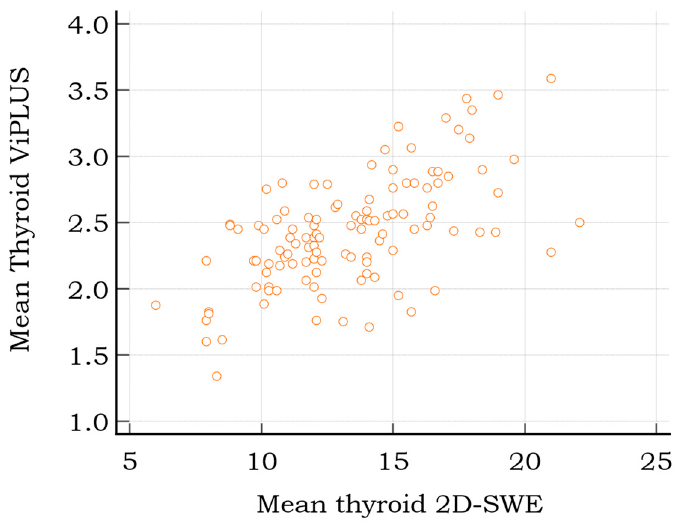
Figure 4. Scatter diagram displaying the relationship between 2D SWE and Vi PLUS thyroid mea- surements for healthy subjects. Table 4. Correlations between 2D SWE, the respective Vi PLUS measurements and patient or mea- surement